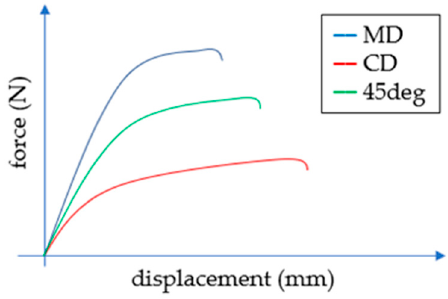
Figure 4. The load–displacement curves in MD, CD and 45 deg.